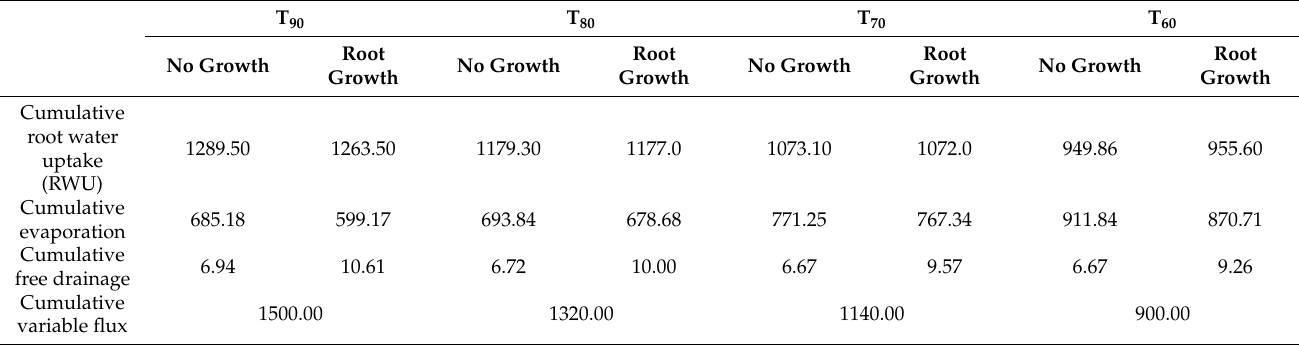
Figure 8. Cumulative RWU, evaporation, free drainage, and variable fluxes for ( a ) T 90 , ( b ) T 80 , ( c ) T 70 , and ( d ) T 60 when deactivating root growth option. Table 6. Selected cumulative fluxes (cm 2 ); RWU, evaporation, free drainage, and variable flux for different irrigation treat-